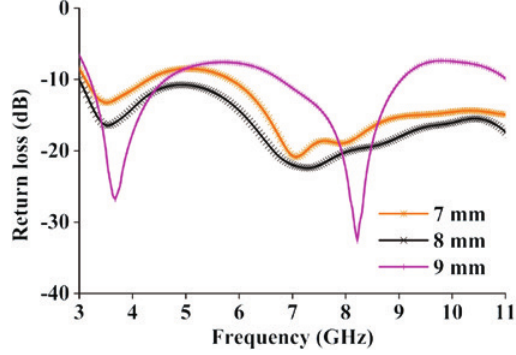
Figure 4: Effects of return loss with different values of R .